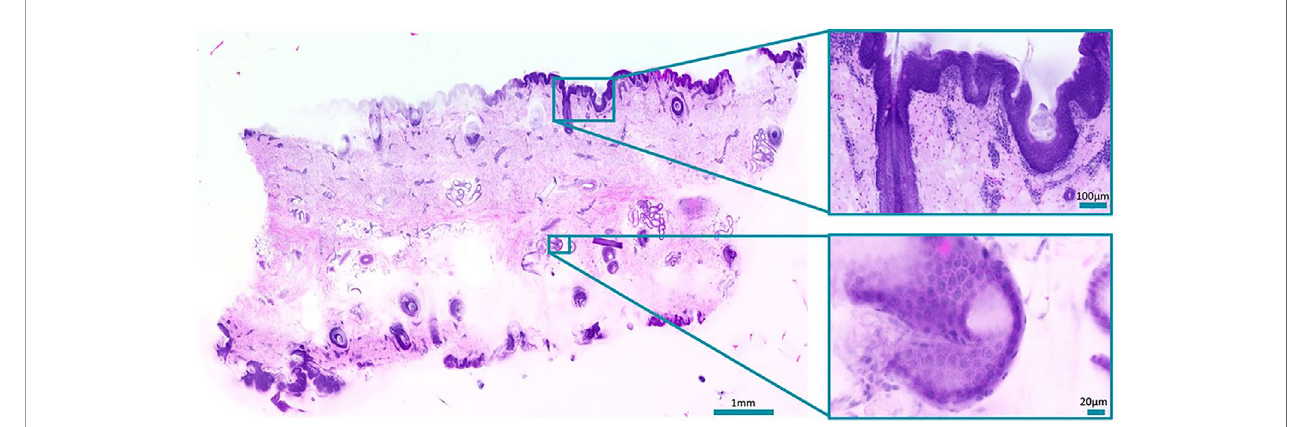
FIGURE 6 | Slide-free image of a bulk porcine skin sample stained with acridine orange and sulforhodamine 101. Zoom-ins show a hair follicle (top) and a sweat duct (bottom). Total acquisition took 13 minutes plus. 10 minutes